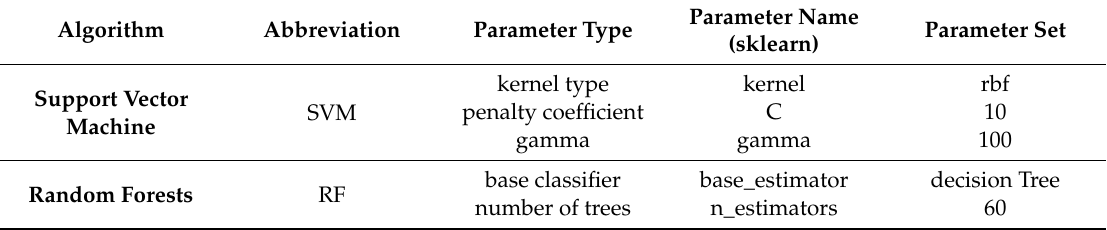
Table 2. Parameters of classifiers used in our experiments (Python